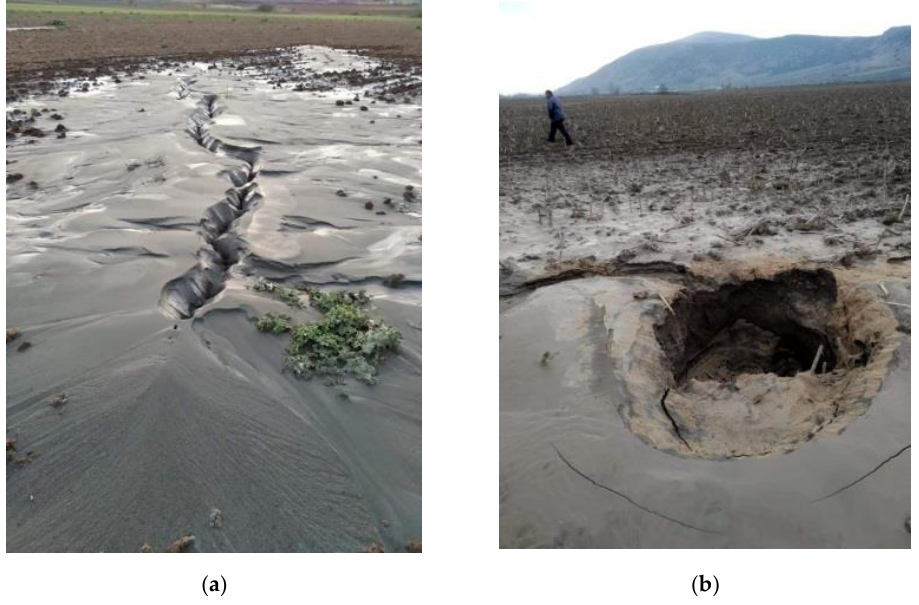
Figure 3. ( a , b ). Soil liquefaction observed after the 3 March 2021 M w = 6.3 earthquake near the Pinior river bank, a few km east of Piniada village (see location in Figure 1).